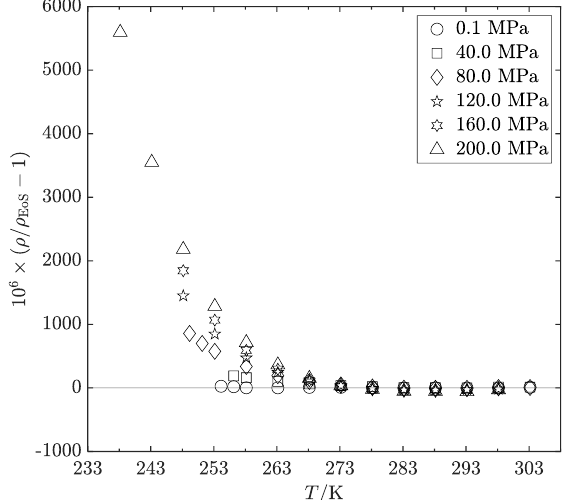
Fig. 4. Density isobars of standard seawater (absolute salinity 35.16504 g · kg -1 ).